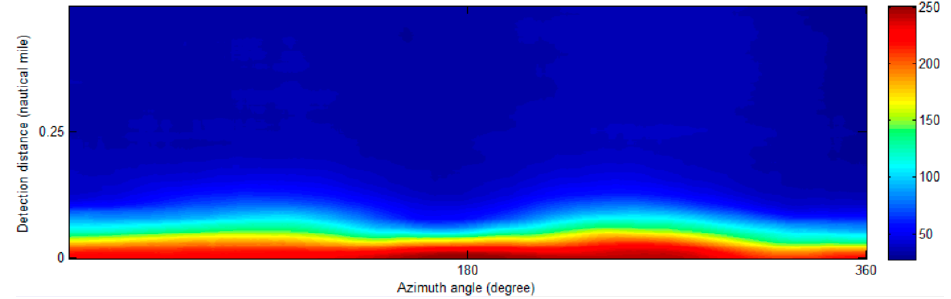
Figure 22. Comparison of segmentation results with different methods: ( a – d ) Results from the methods proposed by Zhu et al. [24], Liu et al. [25], Xu et al. [26], and our method, respectively.